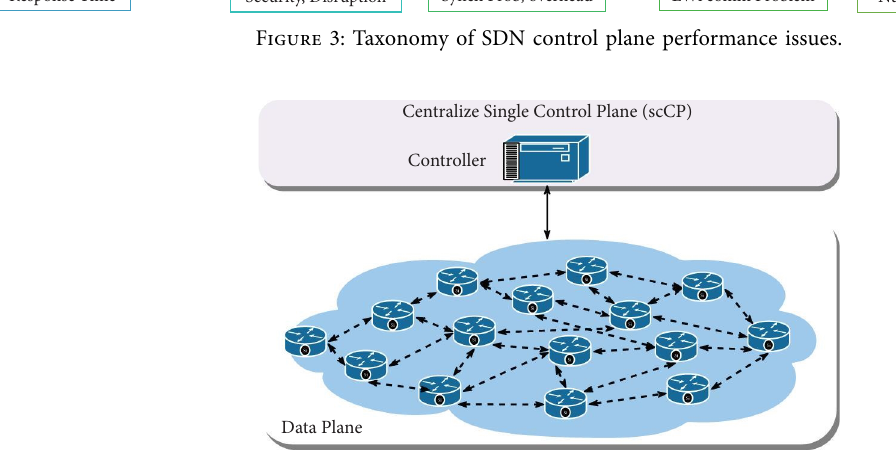
Figure 4: Single control plane Table 2: Comparison of controllers.